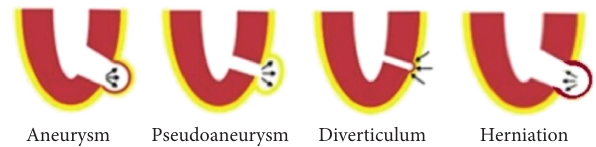
Figure 1: Summary illustration including each type of cardiac outpouching (adapted from A. Cresti et al., J Cardiovasc Echog- raphy, 28, 9–17.